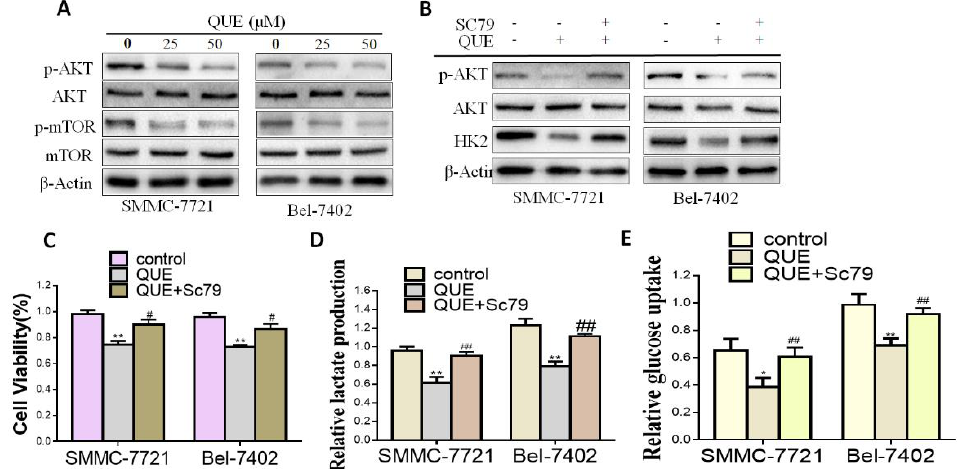
Figure 3. QUE suppressed HCC cells glycolysis through Akt-mTOR pathway. ( A ) Western blot analyses of the e ff ect of QUE on the expression of p-Akt / Akt, p-mTOR / mTOR. β -Actin was used as the invariant control. ( B ) HCC cells were cultured with or without SC79 (5 µ g / mL) for indicated time after QUE (50 µ M) treatment and then the following measurements were performed: cell proliferation rate ( C ), lactate production ( D ), glucose consumption. ( E ) Representatives were from three parallel experiments (* P < 0.05; ** P < 0.01 vs. control group; # P < 0.05; ## P < 0.01 vs. QUE treatment